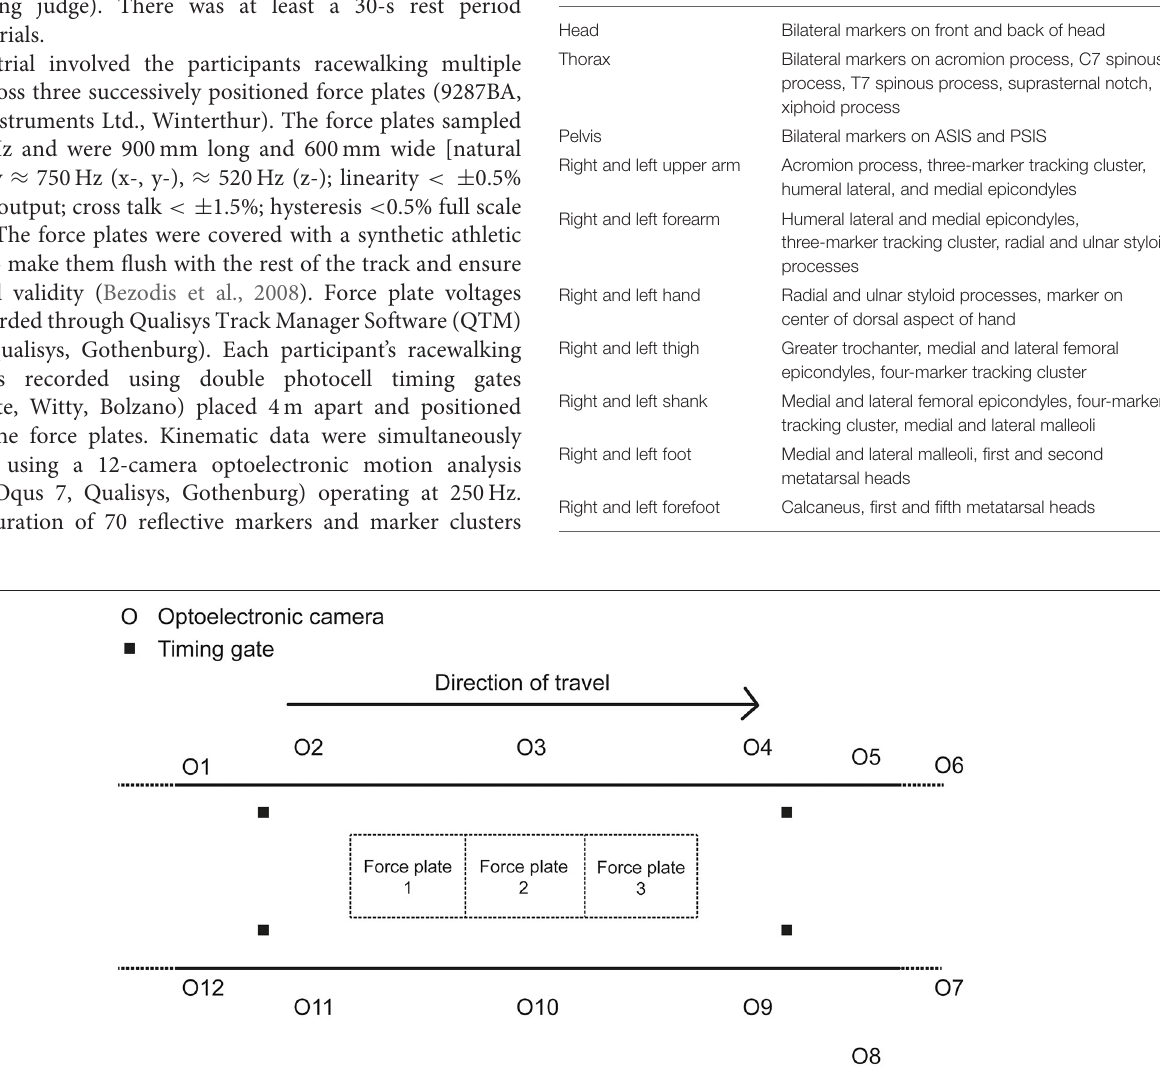
FIGURE 1 | Diagram of the set-up of the data collection area in the biomechanics laboratory.